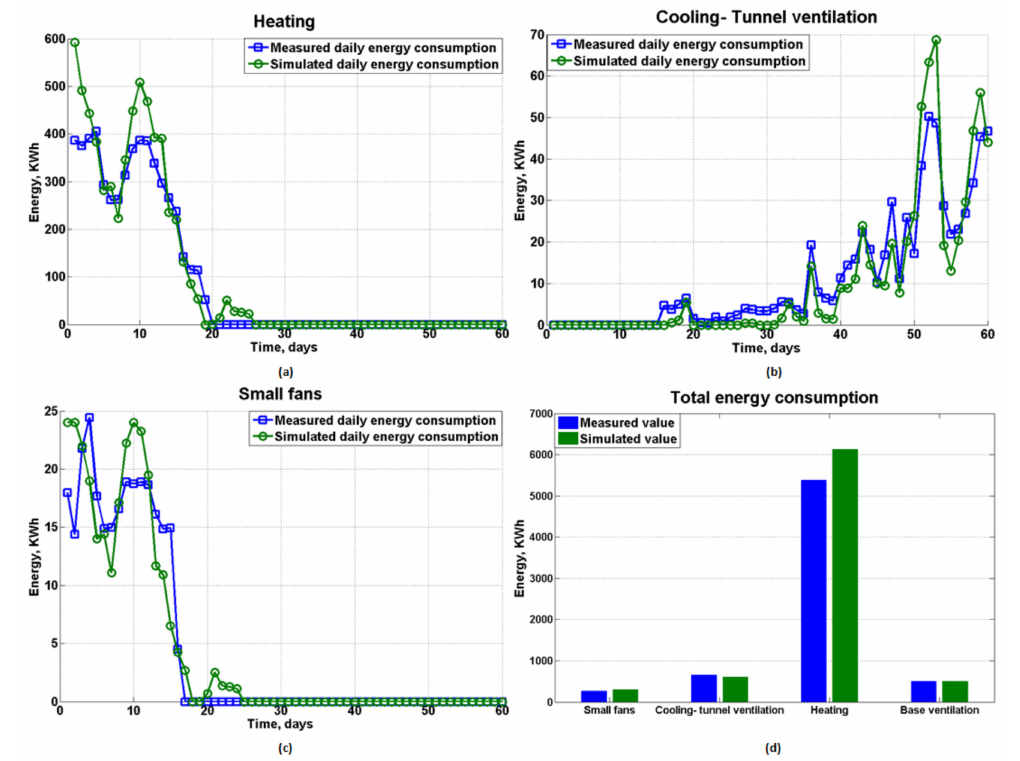
Figure 15. Daily energy consumption and total energy consumption for different aspects. ( a ) Heating; ( b ) Cooling-tunnel ventilation; ( c ) small fans and ( d ) Total energy